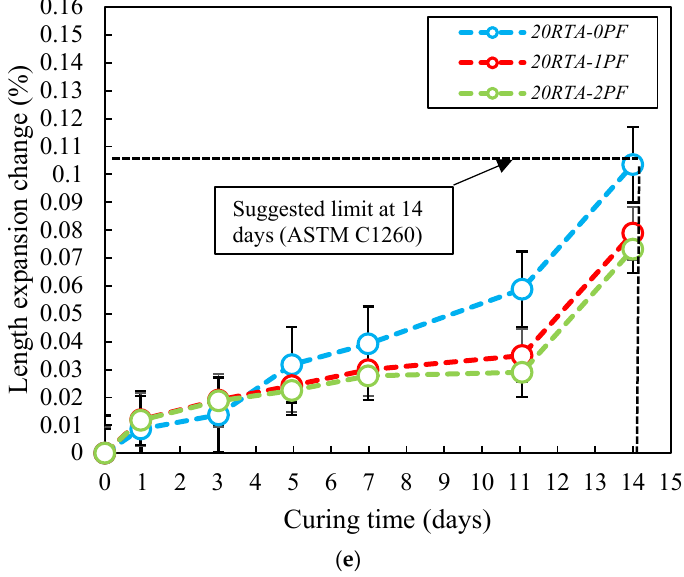
Figure 19. Influence of PF and RTA on the length growth. ( a ) without RTA, ( b ) with 5% RTA, ( c ) with 10% RTA, ( d ) with 15% RTA and ( e ) with 20% RTA